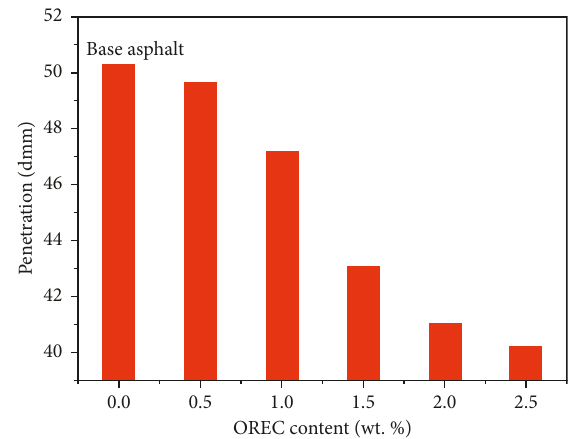
Figure 2: The penetration of WPP/OREC-modified